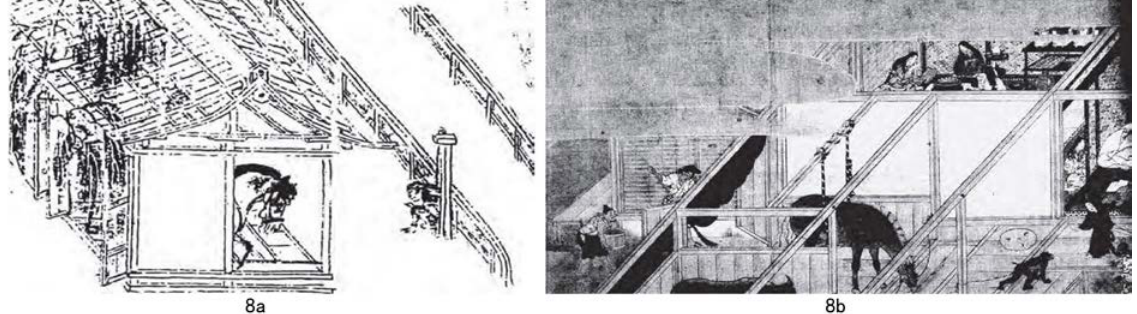
Figure 8. Horse and monkey in Japanese paintings: a) Painting of Ippe, Japan (Chikash 1996); b) Painting of Shishansi (Komatsu